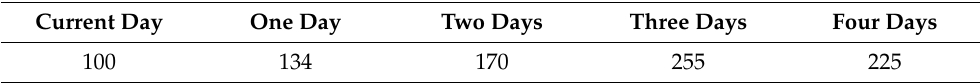
Table 1. Training data are classified by an experienced tomato farmer.